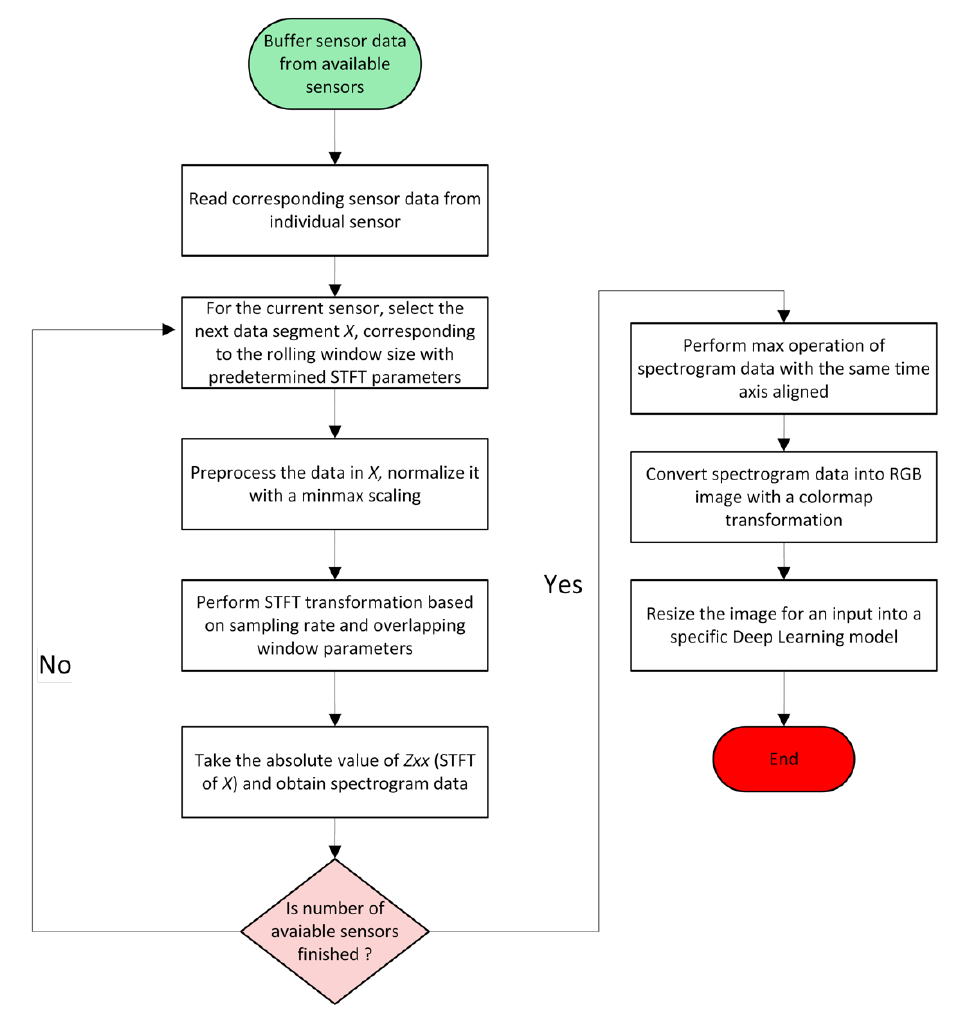
Figure 2. STFT image transformation flow chart detailing a step-by-step of the proposed sensor fusion algorithm.